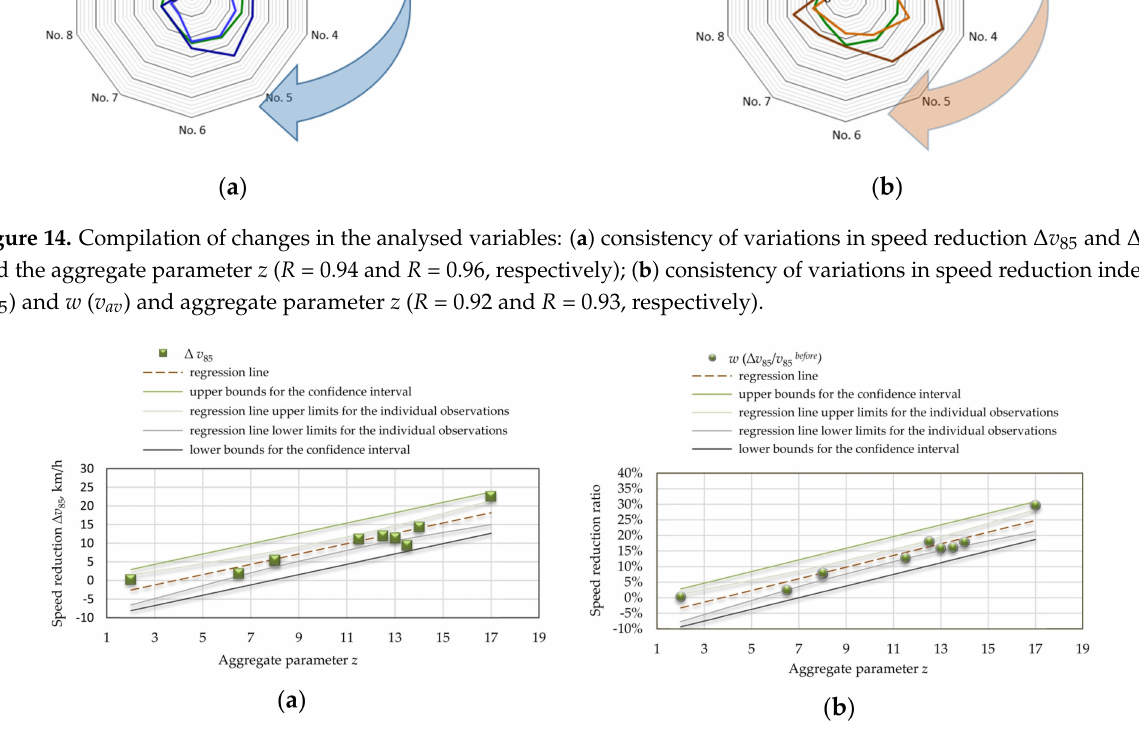
Figure 15. Linear regression function defining the relationship between: ( a ) free-flow speed reduction ∆ v 85 and the aggregate parameter z , ( R = 0.94); ( b ) free-flow speed reduction index w ( v 85 ) and the aggregate parameter z ( R = 0.96).